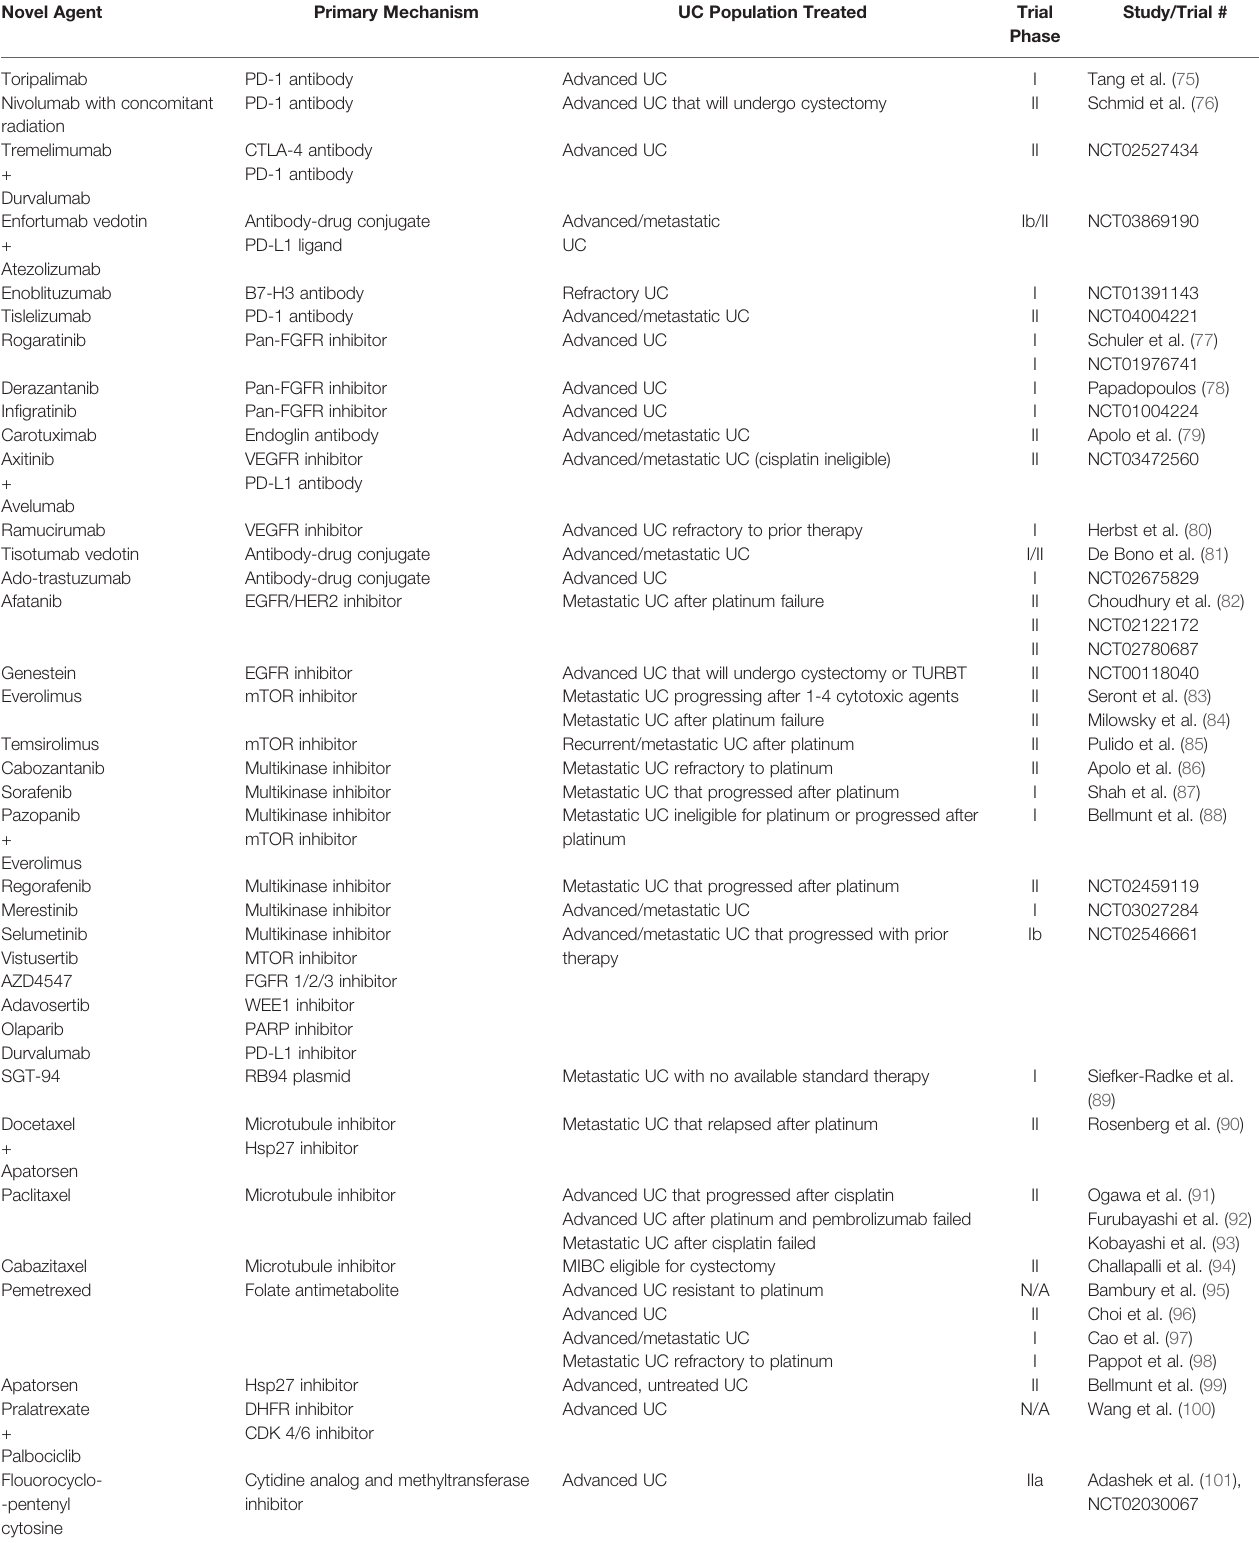
TABLE 2 | Emerging therapies for advanced/metastatic UC or